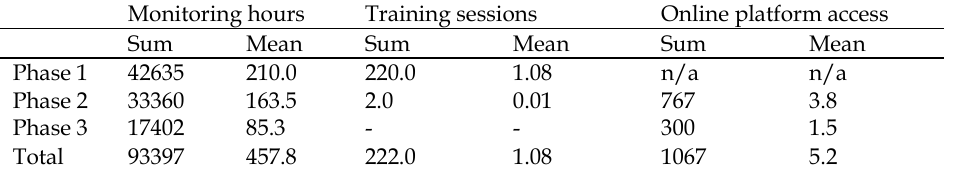
Table 3. Drivers’ monitoring hours, participation in training sessions, and access to platform according to the three monitoring